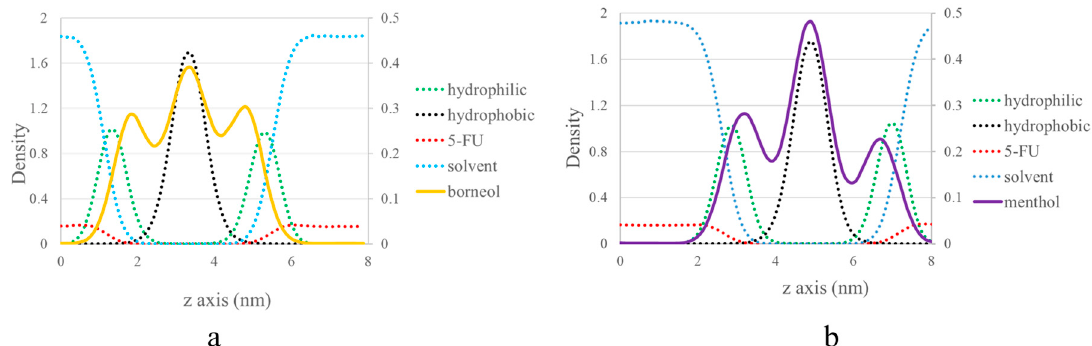
Figure 3. Corresponding density distribution profile of borneol ( a ) and menthol ( b ) along the z -axis at a concentration of 7% by coarse-grained (CG) molecular dynamics (MD). The other four components, including the hydrophilic group of ceramides (CER) (hydrophilic), the hydrophobic group of CER (hydrophobic), the solvent, and 5-FU, are displayed as dotted lines to depict the relative location of borneol and menthol, and their densities are indicated on the first axis on the left side. Because borneol and menthol show low-density distributions in the bilayer, their densities are depicted on the second axis on the right side.